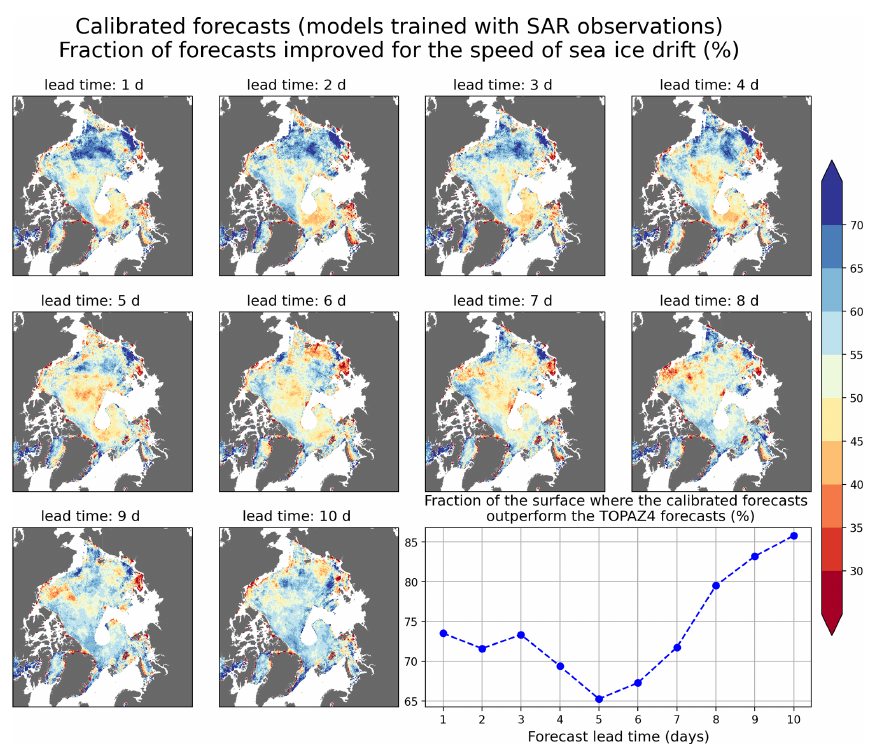
Figure 7. Fraction of calibrated forecasts produced by the models trained with SAR observations which outperform the TOPAZ4 forecasts for the speed of sea ice drift during the period from June 2020 to May 2021. Daily SAR observations have been used as reference. The graph in the lower right corner shows the fraction of the surface where the fraction of calibrated forecasts outperforming the TOPAZ4 forecasts is higher than or equal to 50%.